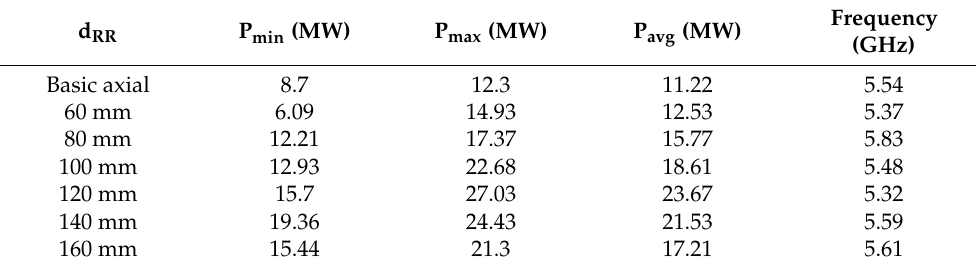
Table 3. Experimental results on the optimum diameter of the hole in the ring